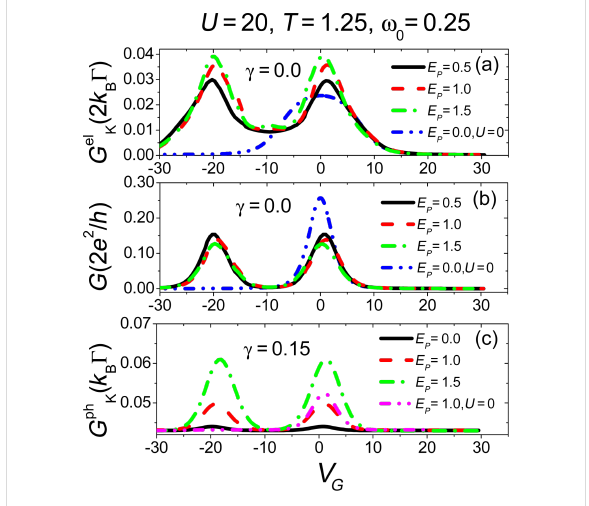
Figure 7: Thermal transport properties in the linear response regime, in the range of validity of the adiabatic approximation and including the electron–electron interaction. Panel (a): Electron thermal conductance in units of 2 k B Γ as a function of the gate voltage V G (in units of ) for different values of electron–vibration coupling E P (in units of ). Panel (b): Same as in panel (a) for the electron conductance G in units of 2 e 2 / h . Panel (c): Phonon thermal conductance (in units of k B Γ ) with the oscillator damping rate γ = 0.15 Γ . Adapted and